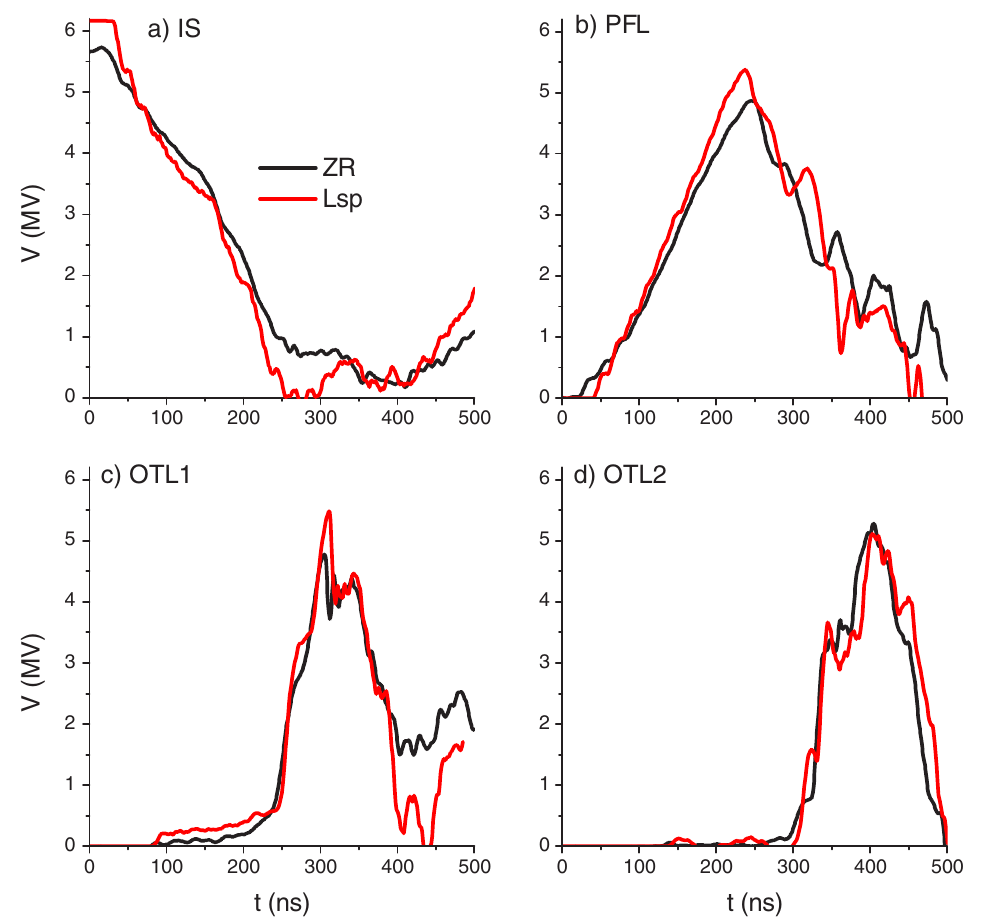
FIG. 4. (Color) Comparison of voltages between ZR-shot 1896 data, module 17 (black curves), and LSP simulation (red curves) for the upper (a) IS, (b) PFL (c) OTL1, and (d)